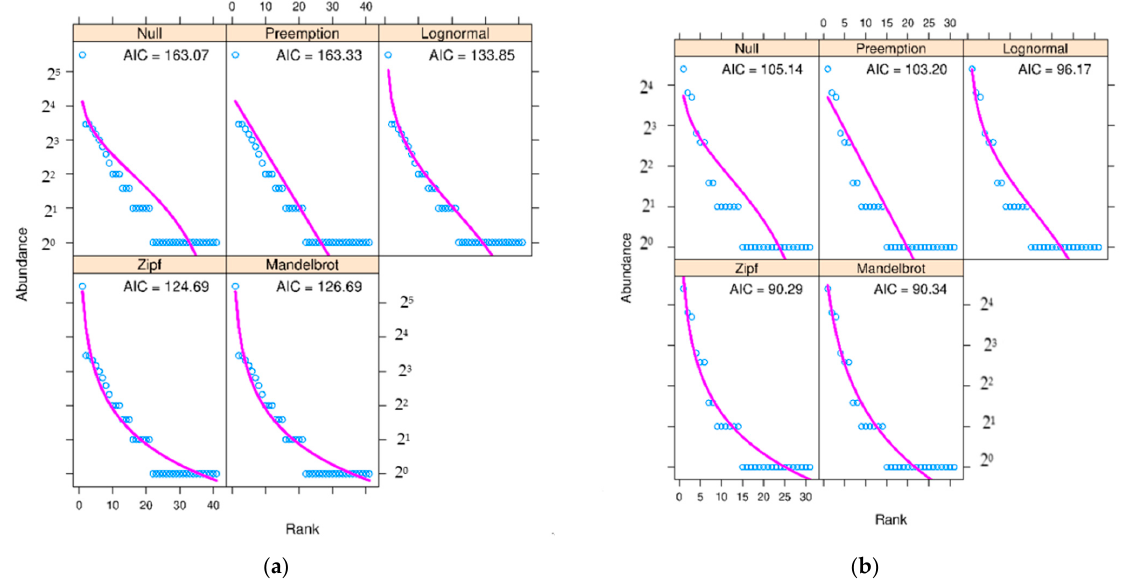
Figure 12. Rank-Abundance Dominance curves with 5 model fits: brokenstick, preemption, log- Normal, Zipf, and Zipf-Mandelbrot. ( a )—anaerobic conditions; ( b )—aerobic conditions (among plants). AIC, Akaike information criterion.